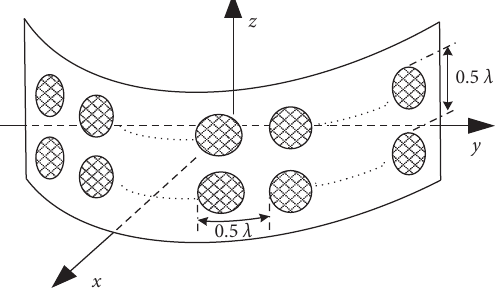
Figure 11: Schematic view of the conformal array with 2 × 40 elements.